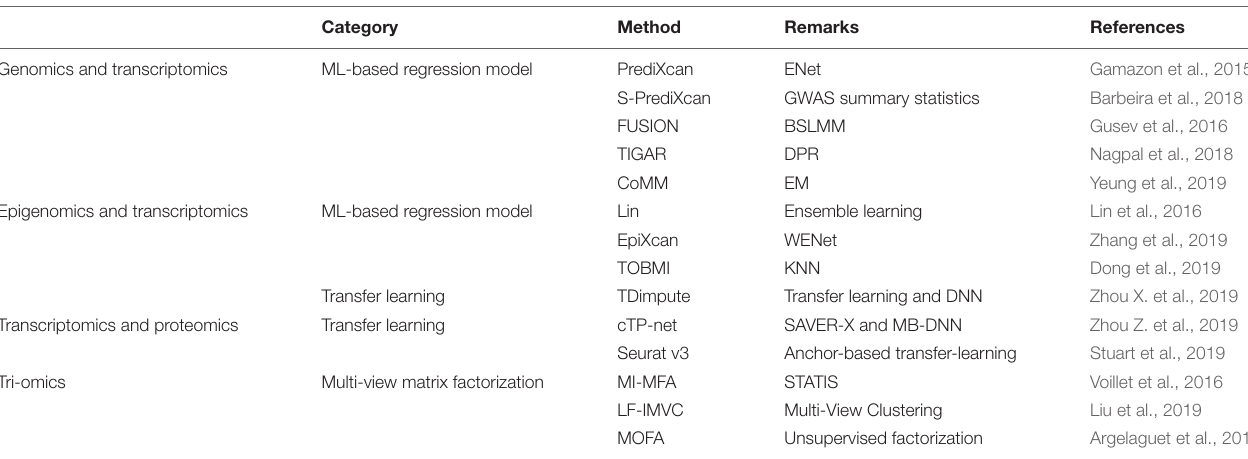
FIGURE 1 | The genetic information flow from DNA to protein via RNA and the interaction between transcriptomics and genomics, epigenomics or proteomics in multi-omics data imputation. The top diagram shows the central dogma of molecular biology in which DNA is transcribed to RNA and then translated to proteins. The bottom diagram shows the integrative relationship between the genomics, epigenomics, transcriptomics and proteomics datasets on which multi-omics data imputation methods are based. These methods are built by combining different omics datasets to perform integrative imputation of missing values. This is shown here by using arrows numbered by the type of data combination they represent. For example, arrow 1 shows that multi-omics imputation can be facilitated by leveraging the correlation between data from both genomics (such as SNP) and transcriptomics (such as gene expression). TABLE 5 | Integrative imputation methods for multi-omics